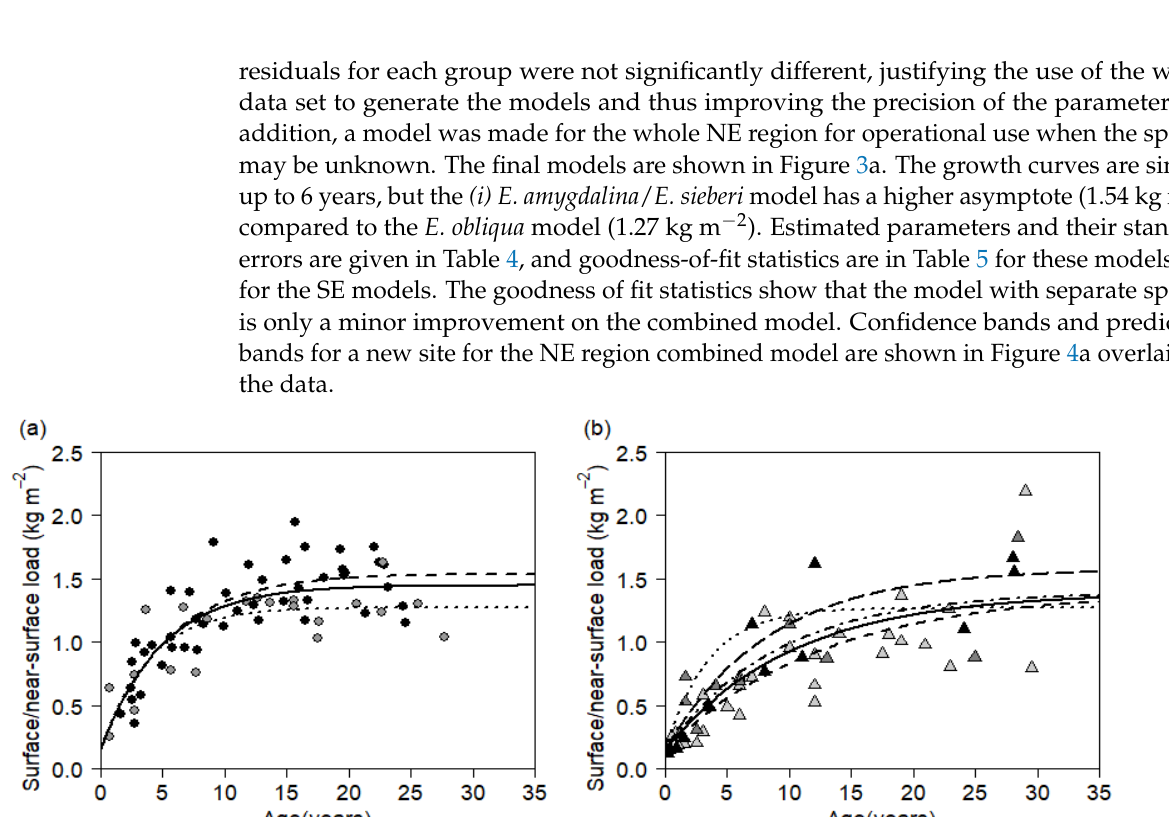
Table 5. Goodness-of-fit statistics for surface/near-surface fuel load models.